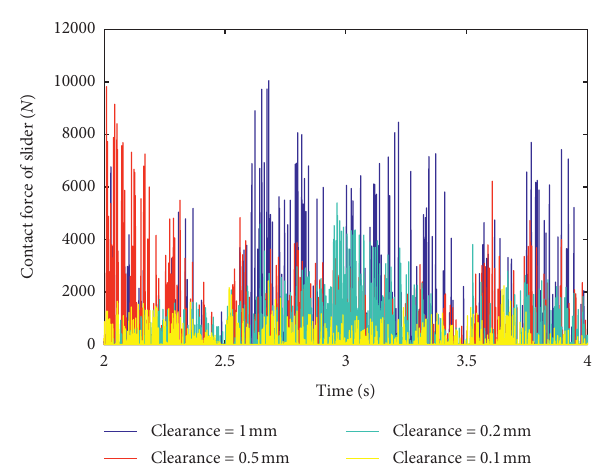
Figure 11: Contact force of the